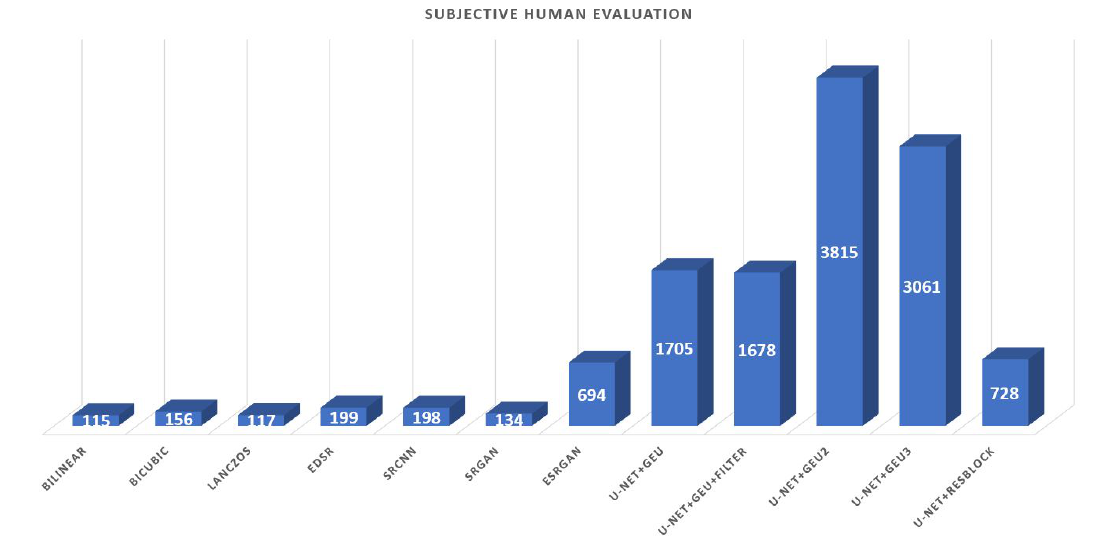
Figure 11. Results of the questionnaire—subjective human evaluation. 100 people attending filled out the questionnaire containing 126 comparisons of 12